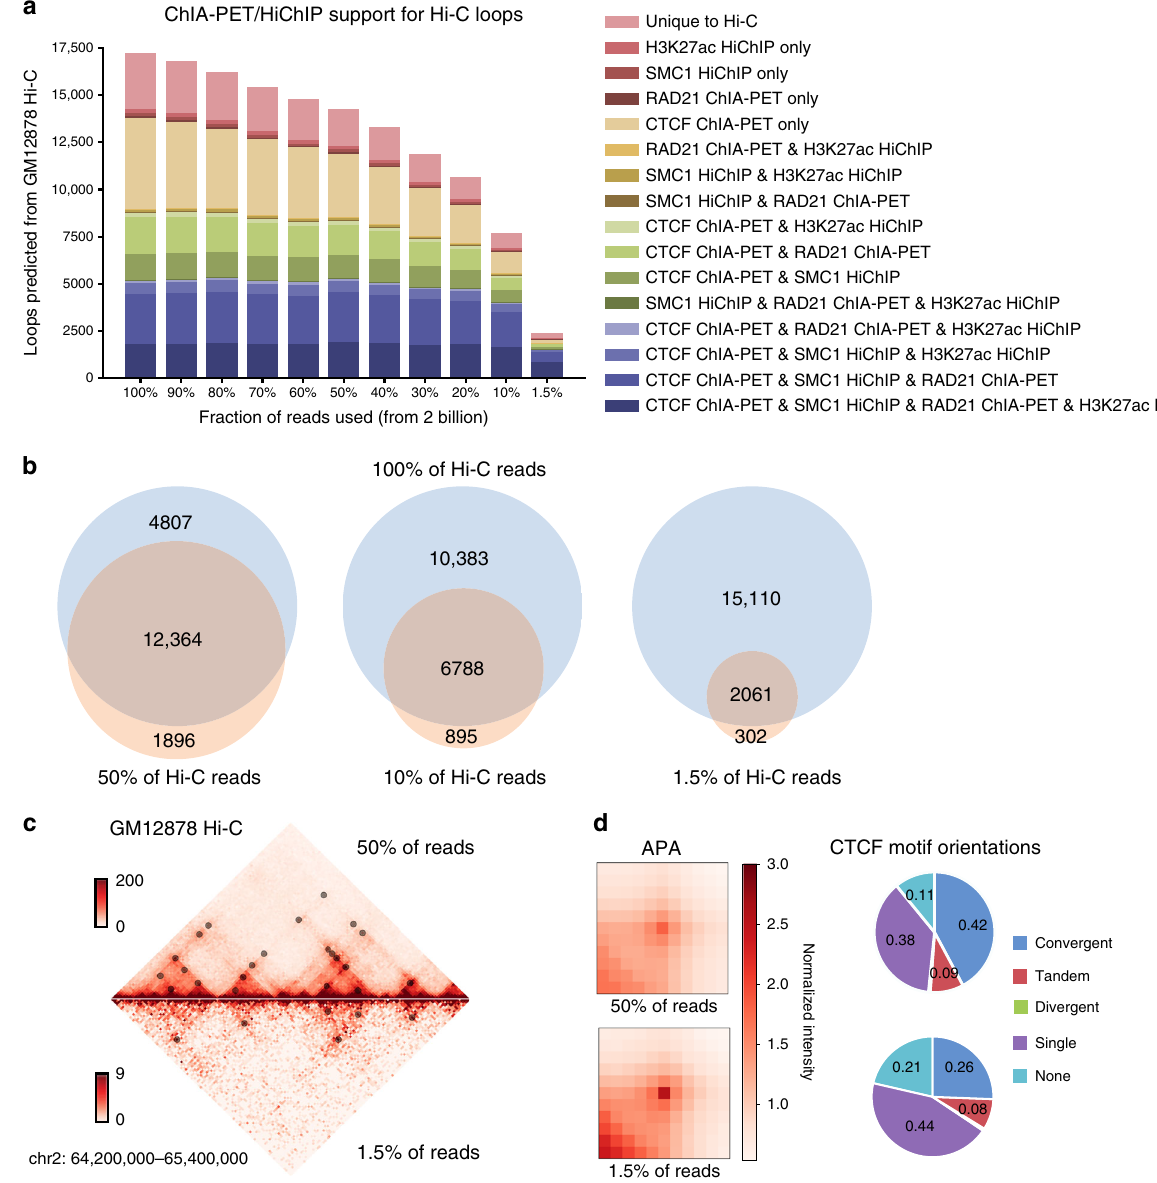
Fig. 4 Detection of loops at lower sequencing depths. a Predicted interactions from down-sampled versions of the GM12878 Hi-C map with levels of validation by orthogonal methods. b Concordance of predictions from datasets with different down-sampled rates. c Visualization of a chromosome 2 locus for Hi-C data and predicted loops using 50% and 1.5% of sequencing reads. d APA pro fi les and CTCF motif orientations of 50% and 1.5% loop predictions. The color bar indicates contact counts normalized by the mean of pixels within their windows. Source data are available in the Source Data fi